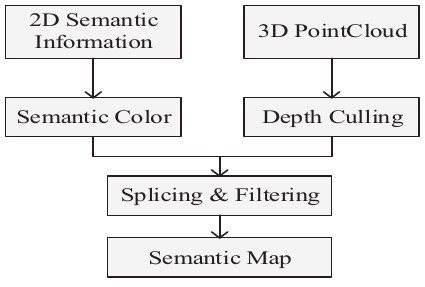
Figure 4. Semantic point cloud